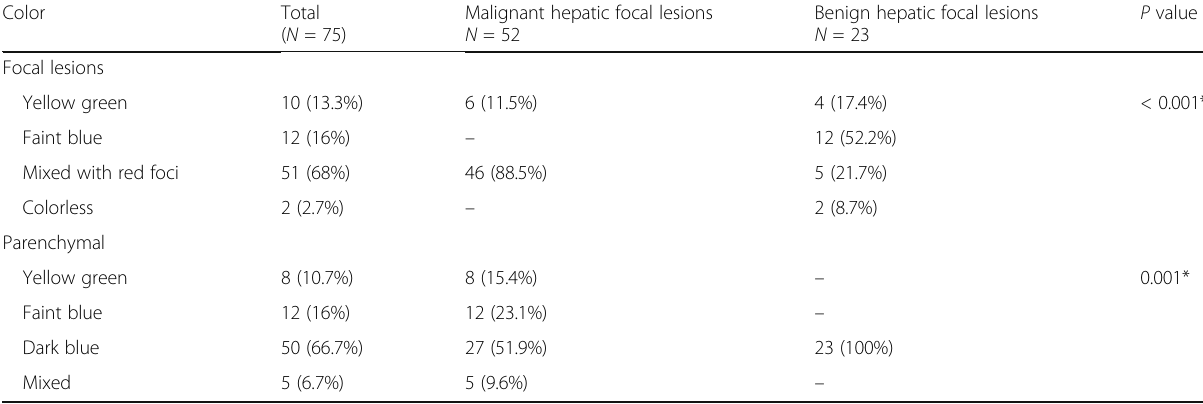
Malignant hepatic focal lesions N = 52 ( N = 75)